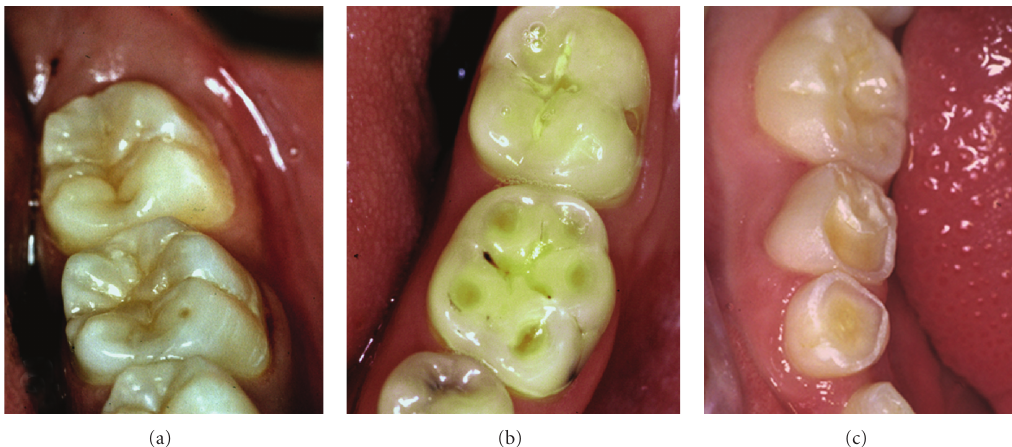
Figure 9: Examples of “cupping” of di ff erent severities in 3 individuals. (a) Cuppings of lesser extent on 36 mesiobuccal cusp in a 20- year-old man who has high intake of cola drinks. (b) Cuppings on 36 in a 22-year-old man with congenital agenesis of salivary glands. (c) Fused cuppings on teeth nos. 84 and 85 in a 5-year-old boy. Published with permission from the Journal of the Swedish Dental Association (Tandl¨akartidningen) [12].